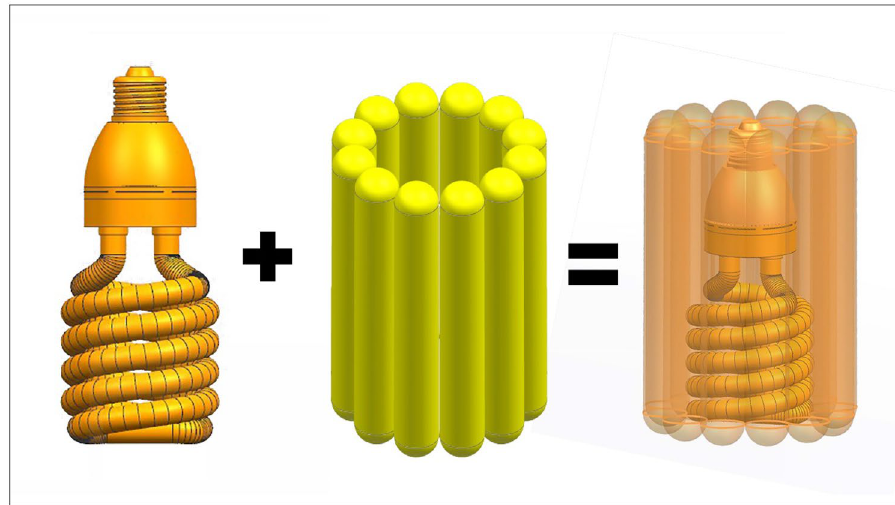
Fig. 3 Geometric model dia- gram of spiral energy-saving lamp package